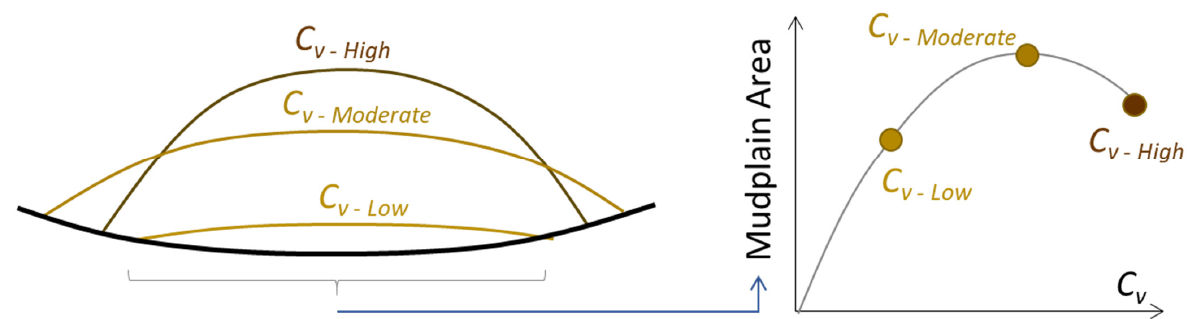
Figure 14. Schematic illustration of potential non ‐ monotonic parametric effects of rheological parameters. When the model uses concentration ‐ dependent rheological parameters the relationship between concentration and inundation area can be non ‐ monotonic, as concentration increases “mounding” and limits lateral runout, which can compensate for volume increases (vertical scale in the schematic exaggerated to illustrate effect).